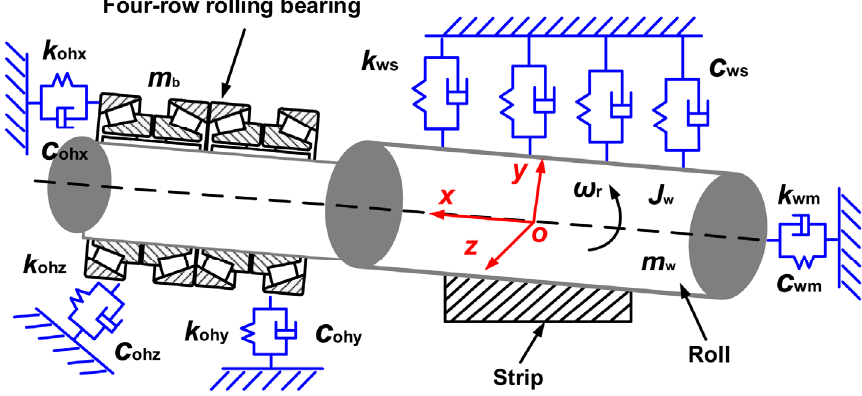
Figure 3. Nonlinear dynamic model of the RBBH system.